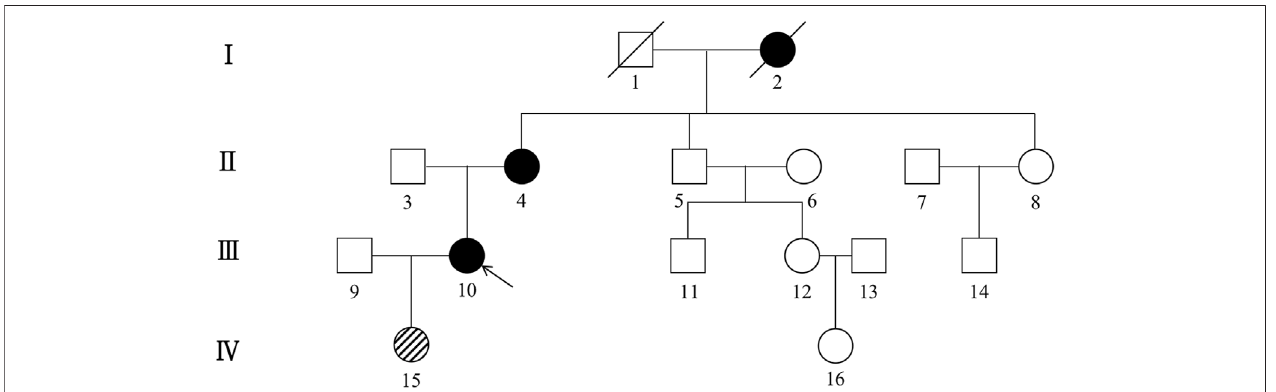
FIGURE 6 | Pedigree of the second Han Chinese family with CSF1R-microglial encephalopathy. The Roman numeral to the left of the pedigree denotes the generation. Women are represented by circles, and men by squares. The arrow indicates the proband (patient III-10). Black symbols represent affected patients, while white symbols represent unaffected individuals or at-risk individuals of unknown phenotype. Oblique symbols represent that the patients with CSF1R mutation were asymptomatic.